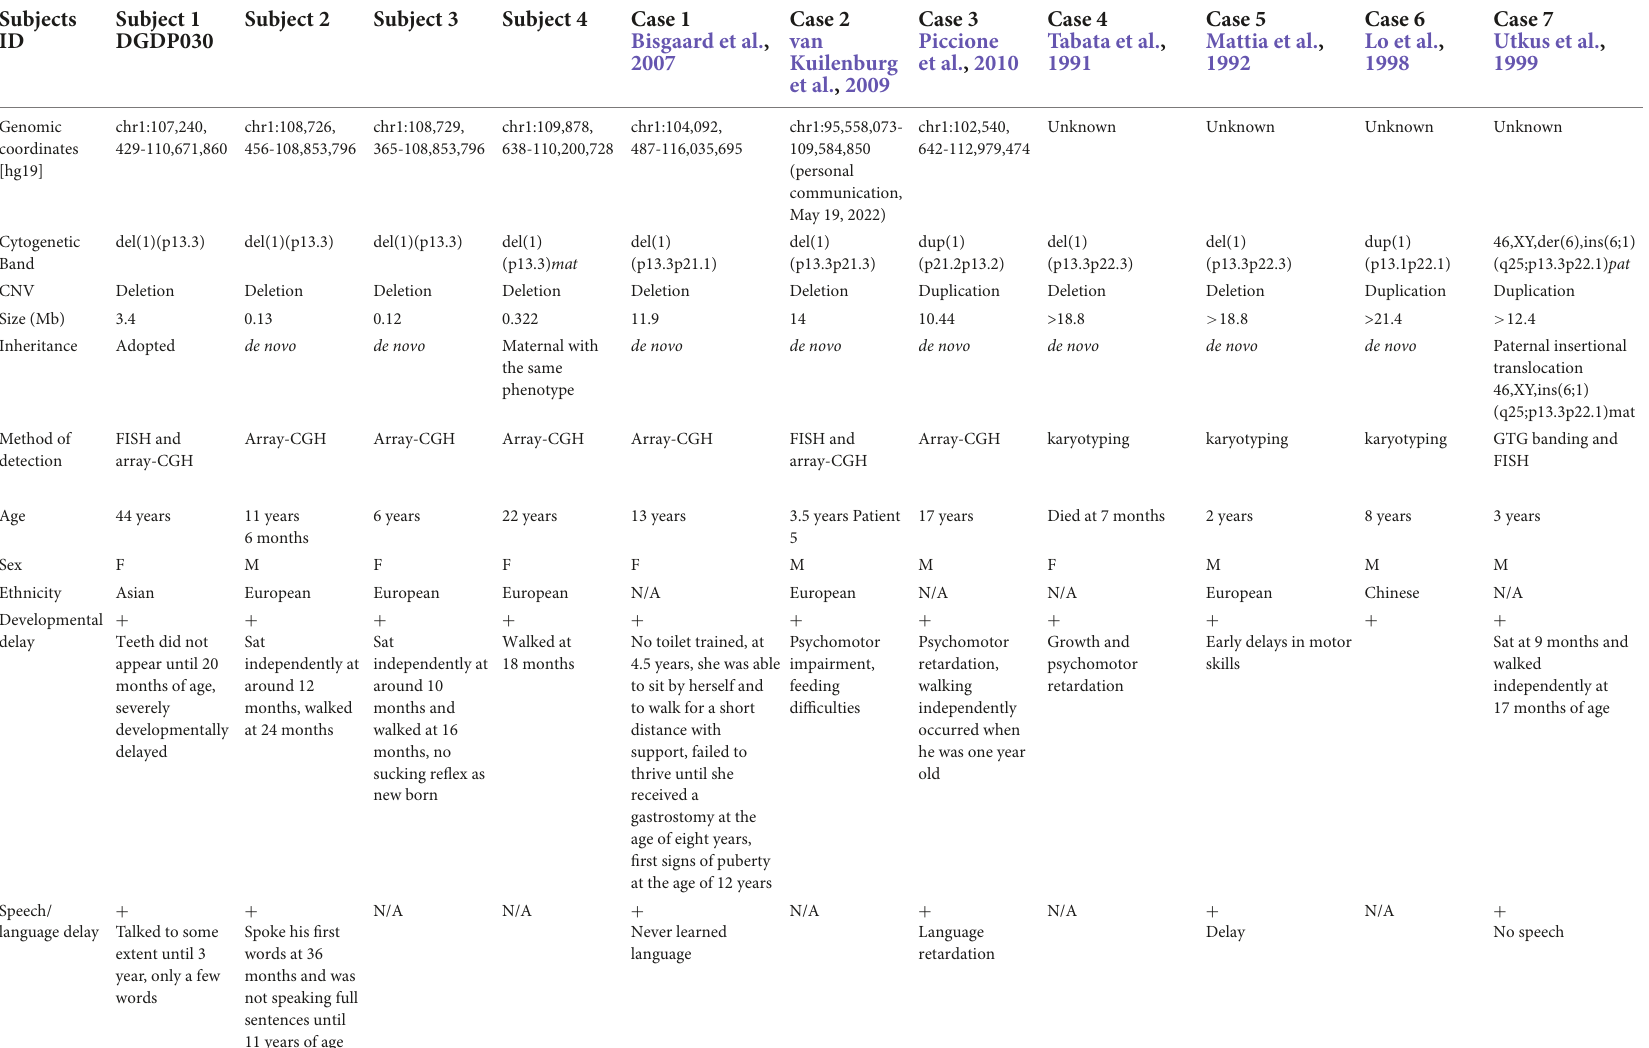
TABLE 1 Clinical features of eleven CNV subjects with 1p13.3 microdeletion/microduplication. Our four CNV carriers 1–4 are indicated here as Subjects